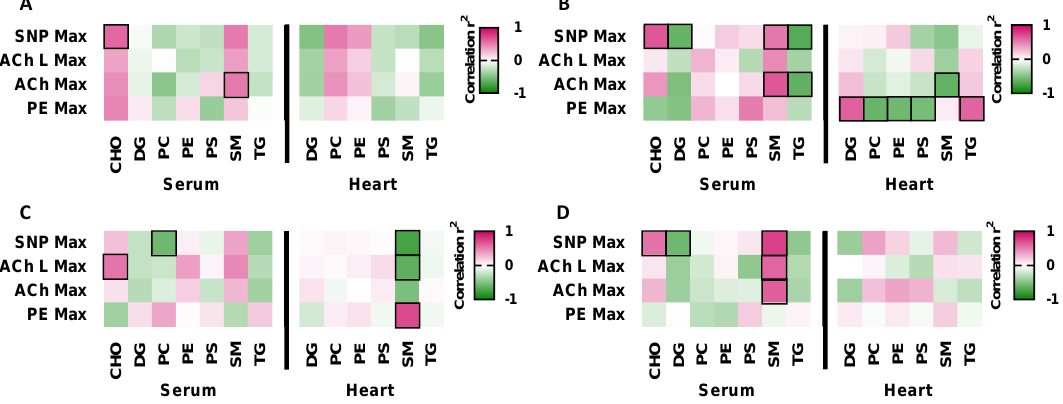
Figure 4. Correlations between serum, heart and brain lipids in F1 adult offspring and vascular function parameters: Correlation between previously reported maximal (max) mesenteric artery responses to phenylephrine (PE Max), acetylcholine (Ach Max), Acetylcholine with N ´ ω -nitro-Larginine methyl ester (L-NAME; ACh L Max) or sodium nitroprusside (SNP Max) with a relative Z-score abundance of serum cholesterol (SHO), diglycerides (SDG; water-loss product from fragmentation in source), phosphatidylcholines (SPC), phosphatidylcholines (SPE), phosphatidylserine (SPS), sphingomyelins (SSM) and triglycerides (STG) as well as heart diglycerides (HDG; water-loss product from fragmentation in source), phosphatidylcholines (HPC), phosphatidylcholines (HPE), phosphatidylserine (HPS), sphingomyelins (HSM) triglycerides (HTG) and cerebrum diglycerides (CDG), phosphatidylcholines (CPC), phosphatidylcholines (CPE), phosphatidylserine (CPS), sphingomyelins (CSM) and triglycerides (CTG). Correlations are reported in ( A ) NN (NPD sperm and LPD seminal plasma), ( B ) LL (LPD sperm and LPD seminal plasma), ( C ) NL (NPD sperm and LPD seminal plasma) and ( D ) LN (LPD sperm and NPD seminal plasma) adult offspring tissues. N = 10–20 offspring (5–10 males and females) per treatment group, sampled from all litters generated. Statistical differences were determined using Pearson’s correlation with significance taken at p < 0.05. Black boxes indicate statistically significant correlations.